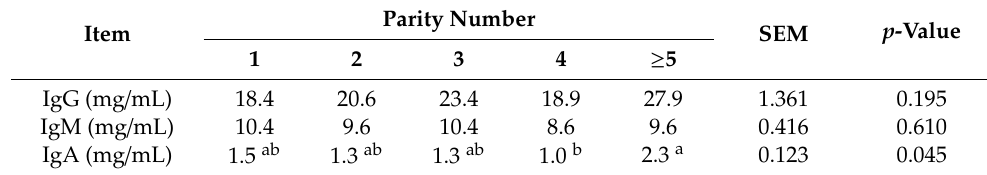
Table 3. E ff ect of parity number on IgG, IgM and IgA sera concentrations in Large-White × Landrace sows at 110 d of gestation.